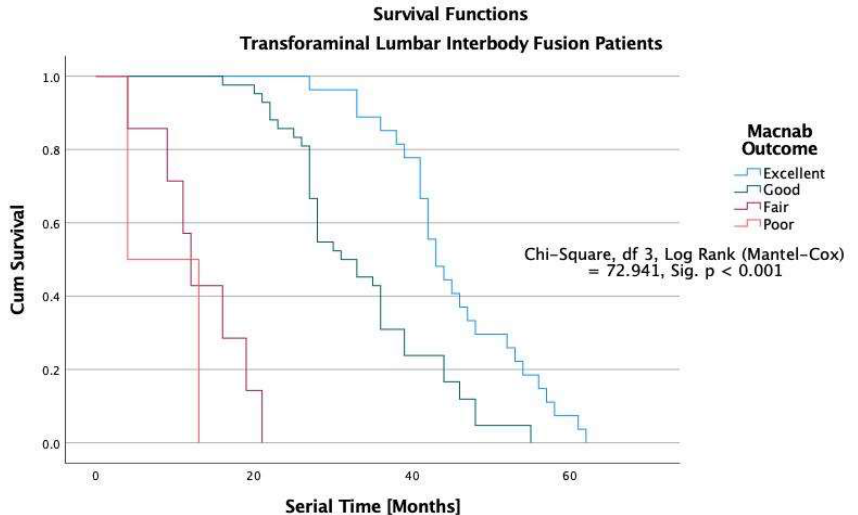
Figure 6. Kaplan-Meier (K-M) Survival functions by Macnab outcomes graphically illustrate the durability of ELD surgery. Patients were censored if they required additional treatment after their index operation or if their outcome was not known at their final follow-up. The estimated median (50% percentile) overall durability (survival) among ELD patients ( n = 206) was 54 months with a standard error of 2.392, a lower boundary of 49.311, and an upper boundary of 58.689 months. The survival time in ELD patients with Excellent Macnab outcomes was 62 months with a standard error of 0.982, a lower boundary of 60.076, and an upper boundary of 63.924 months (Table 4).